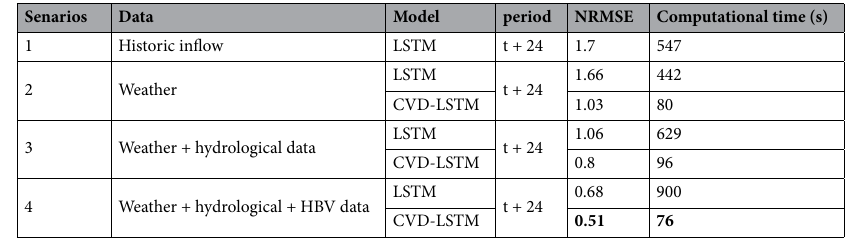
Table 5. Comparison of input data impact on LSTM and CVD-LSTM performance. Significant values are in